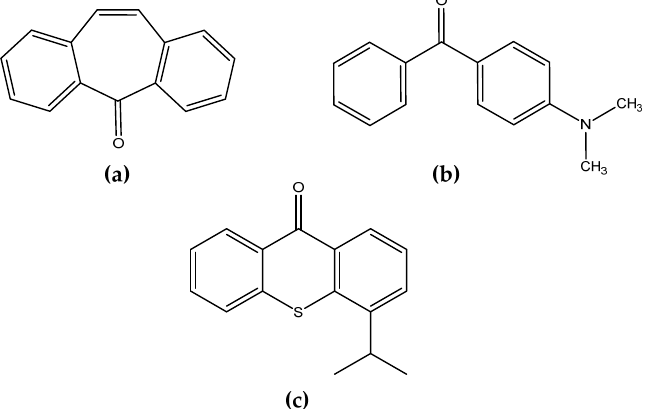
Figure 2. Photoinitiators used: ( a ) dibenzosuberonene (DBS), ( b ) 4-(dimethylamino)benzophenone (DMABP), and ( c ) isopropylthioxanthone (ITX).